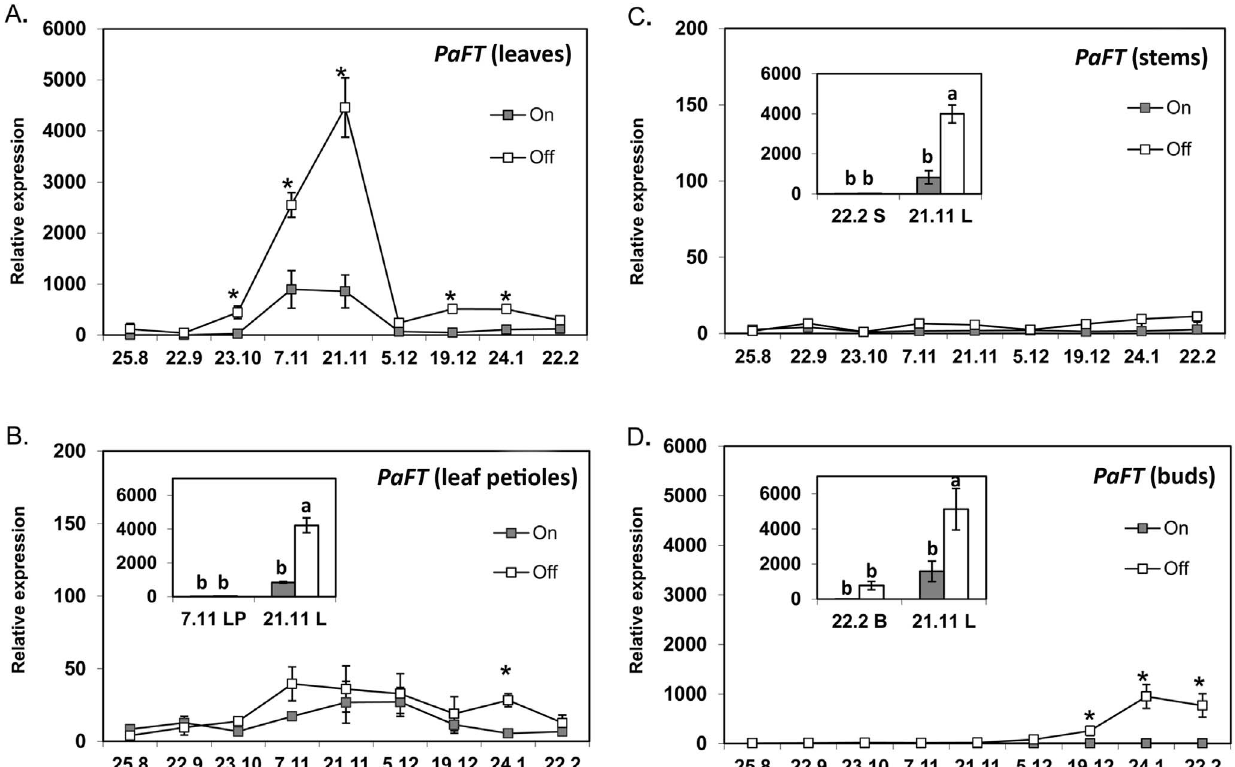
Figure 7. Seasonal expression profiles of PaFT . Seasonal expression profiles of PaFT in leaves (A), leaf petioles (B), stems (C) and buds (D) from fully loaded ( on ) and completely de-fruited ( off ) ‘Hass’ trees are presented. Off trees correspond to trees from which fruit load was completely removed in July. Data are means 6 SE of three independent replicates (n=3 trees). Stars denote a significant difference between transcript expression in on and off tissues at the same time point ( P , 0.05). Insets: PaFT expression in leaves (L) vs. leaf petioles (LP), ( B ) in leaves (L) vs. stems (S), ( C ) and in leaves (L) vs. buds (B) ( D ). Different letters indicate statistically significant differences ( P , 0.05). Sampling dates are presented as dd/m.